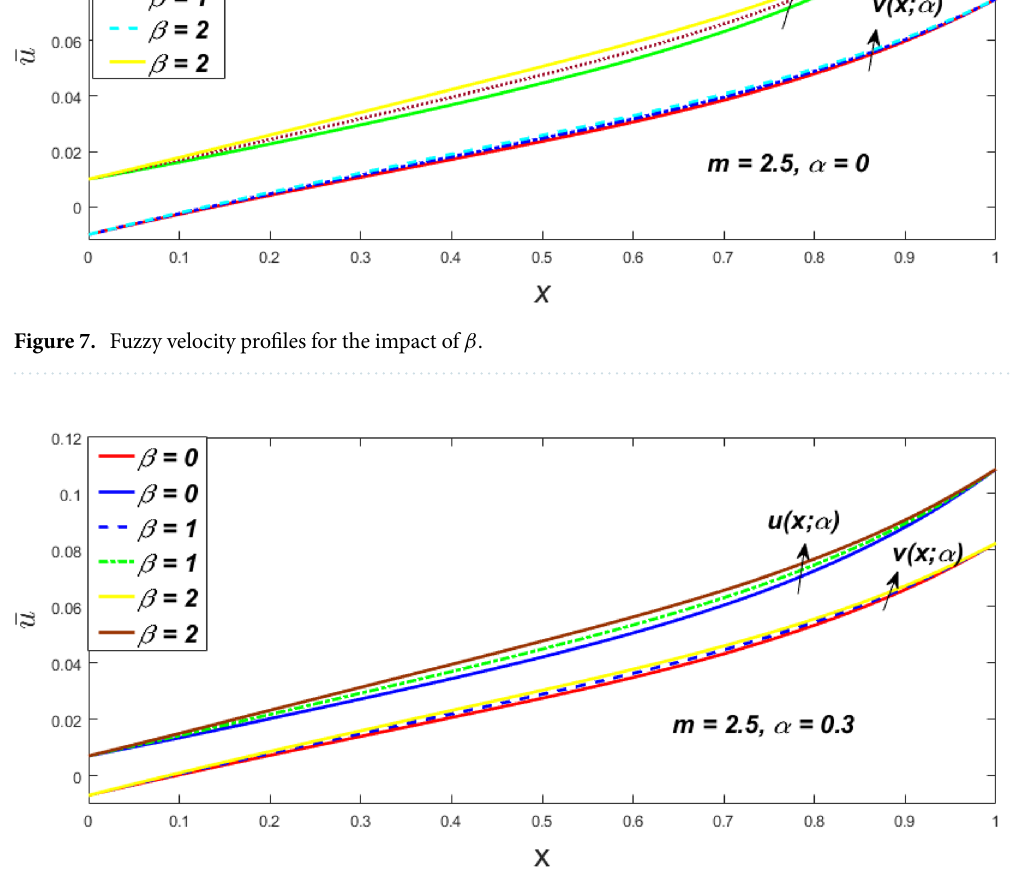
Figure 8. Fuzzy velocity profiles for the impact of β .